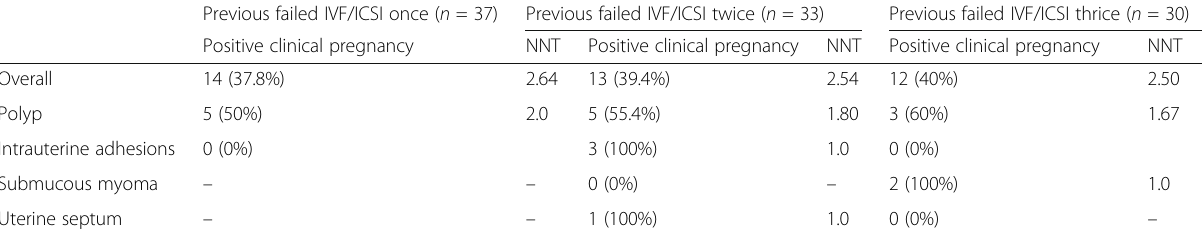
Table 4 The impact of hysteroscopy and intervention on clinical pregnancy rate in women according to number of previous failed IVF/ICSI trials